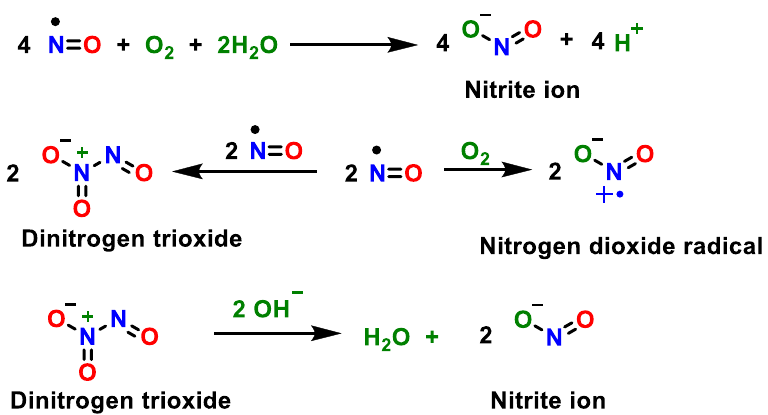
Figure 3. Oxidation of • NO to • NO 2 and oxidation in aqueous solution to nitrite ion NO 2 −